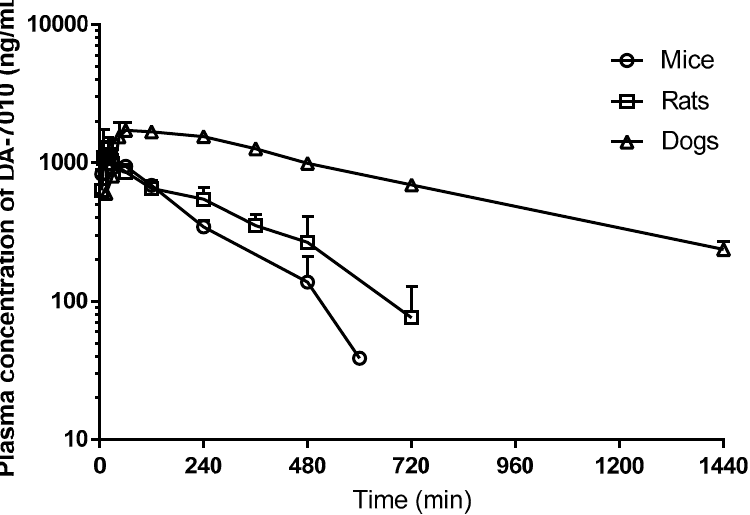
Figure 4. Mean arterial plasma concentration–time profiles of DA-7010 following oral administration of DA-7010 at a dose of 3 mg/kg to mice ( n = 6 for each point), rats ( n = 7), and dogs ( n = 4). Data are expressed as mean ± SD. Table 4. Pharmacokinetic parameters for DA-7010 after single oral administration at a dose of 3 mg/kg to mice, rats, and dogs.